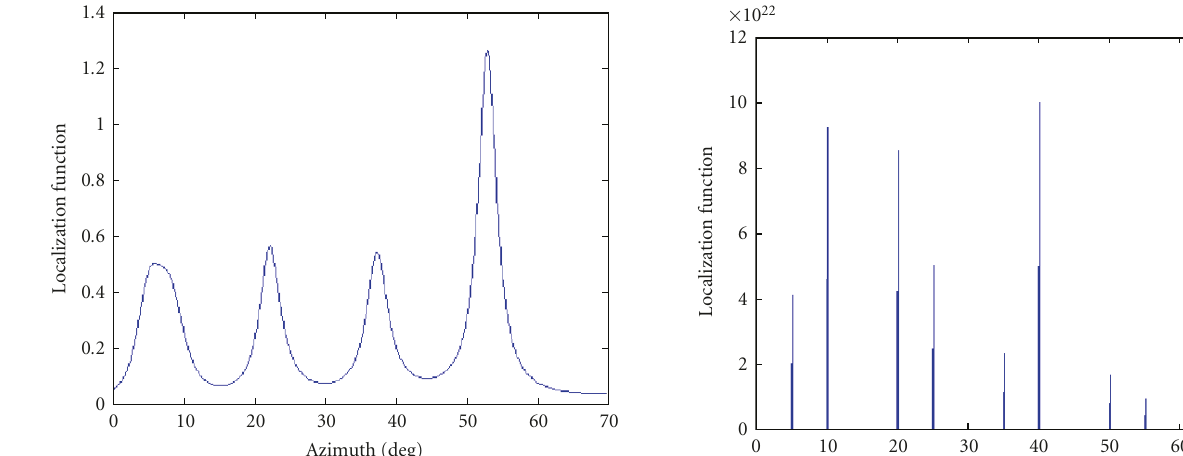
Figure 2: Π U -propagator with SNR = 0 dB.